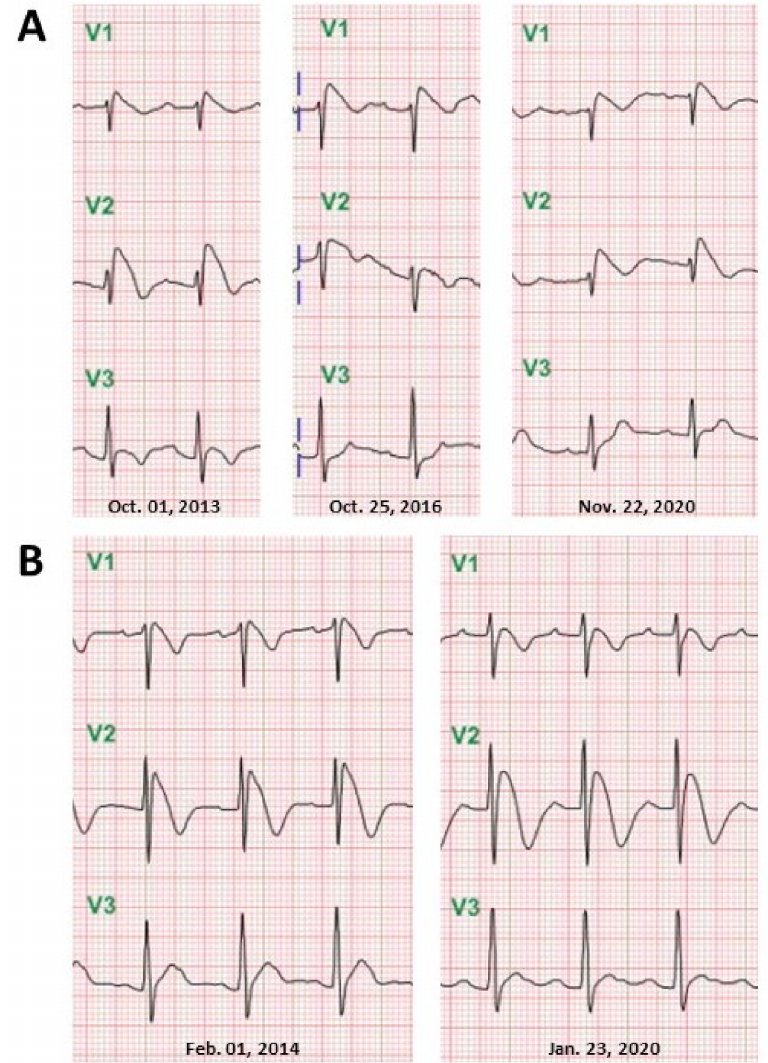
Figure 4. Recurrence of fever-induced Brugada ECG pattern. Admission ECGs displaying recurrences of coved-type ST-segment elevation accompanying repeated febrile episodes in ( A ) an 83-year-old man on 1 October 2013: Klebsiella pneumoniae sepsis (temperature, 39.8 ◦ C); on 25 October 2016: upper respiratory tract infection (temperature, 39.2 ◦ C); on 22 November 2020: pneumonia (temperature, 38.5 ◦ C); ( B ) a 21-year-old man on 1 February 2014: infectious diarrhea (temperature, 38.3 ◦ C) and on 23 January 2020: infectious diarrhea (temperature, 38.7 ◦